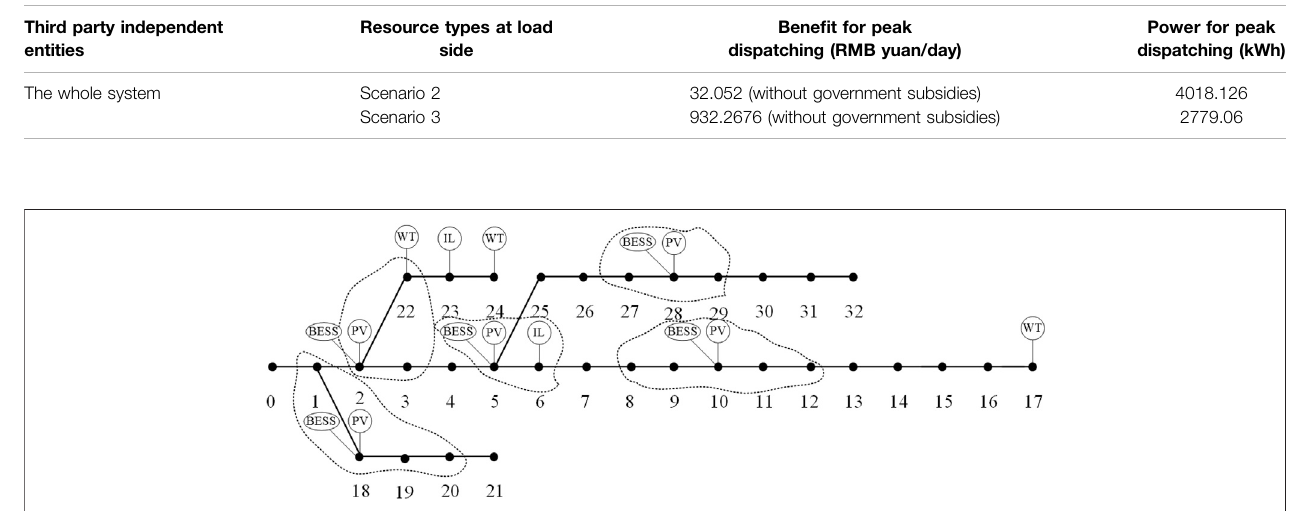
TABLE 2 | Bene fi t for peak dispatching.